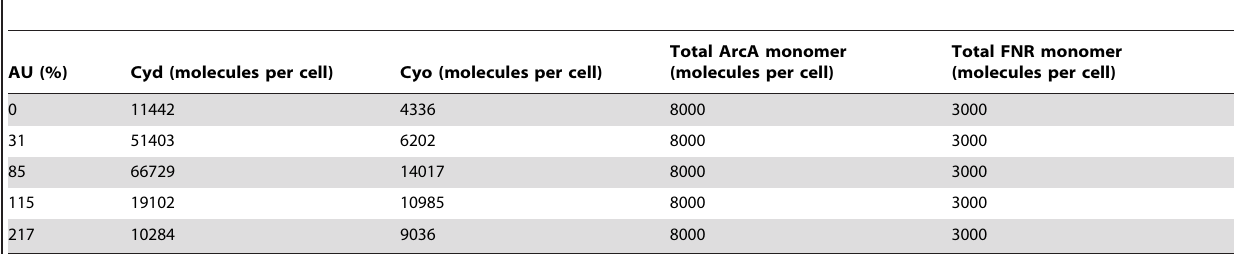
Table 1. Numbers of Cyd, Cyo, ArcA and FNR molecules per E. coli cell at different points on the aerobiosis scale.